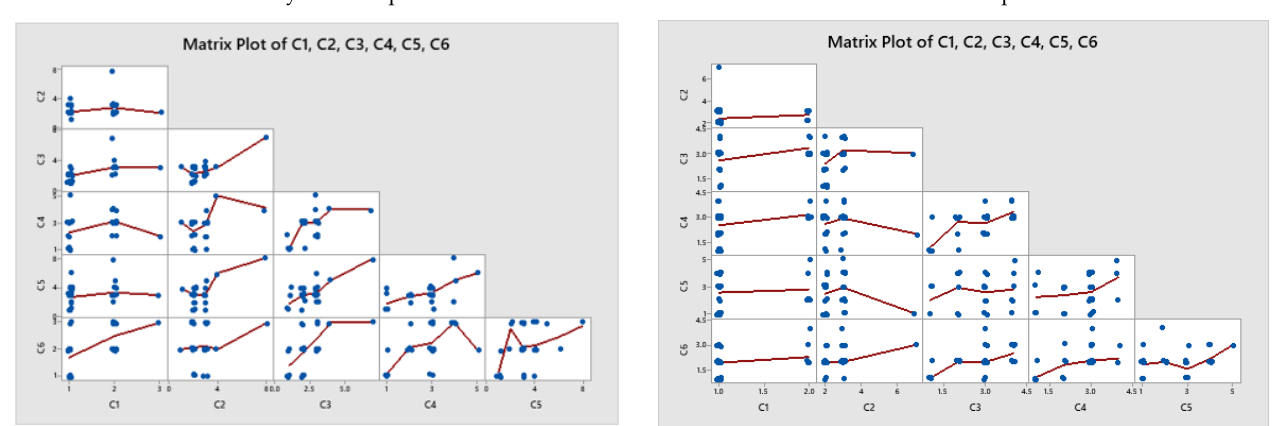
Figure 2. The matrix of Cronbach alpha analysis using Minitab ® (electricity and gas consumption).